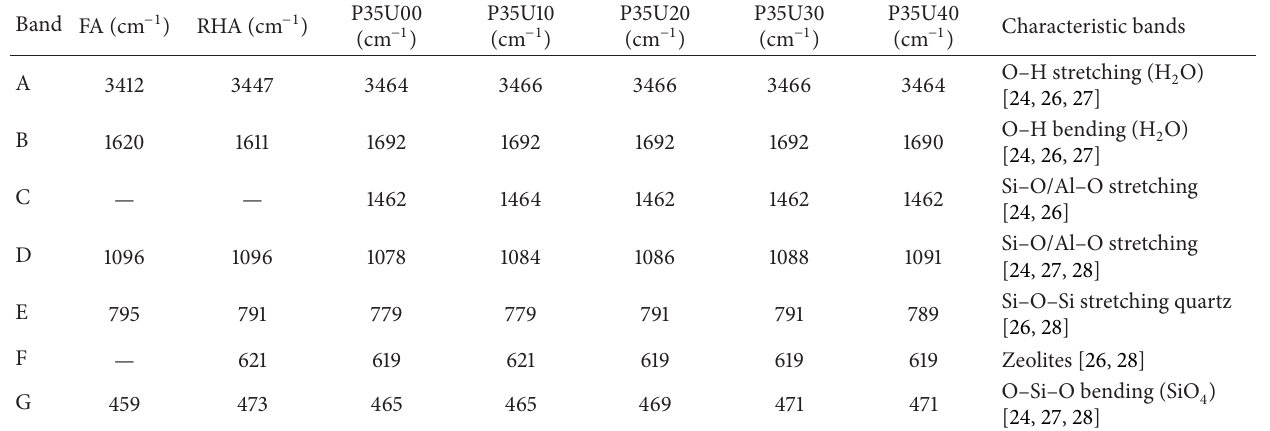
Table 4: FTIR characteristic bands identified in the FA and RHA powders and brick specimens shown in Figure 8.